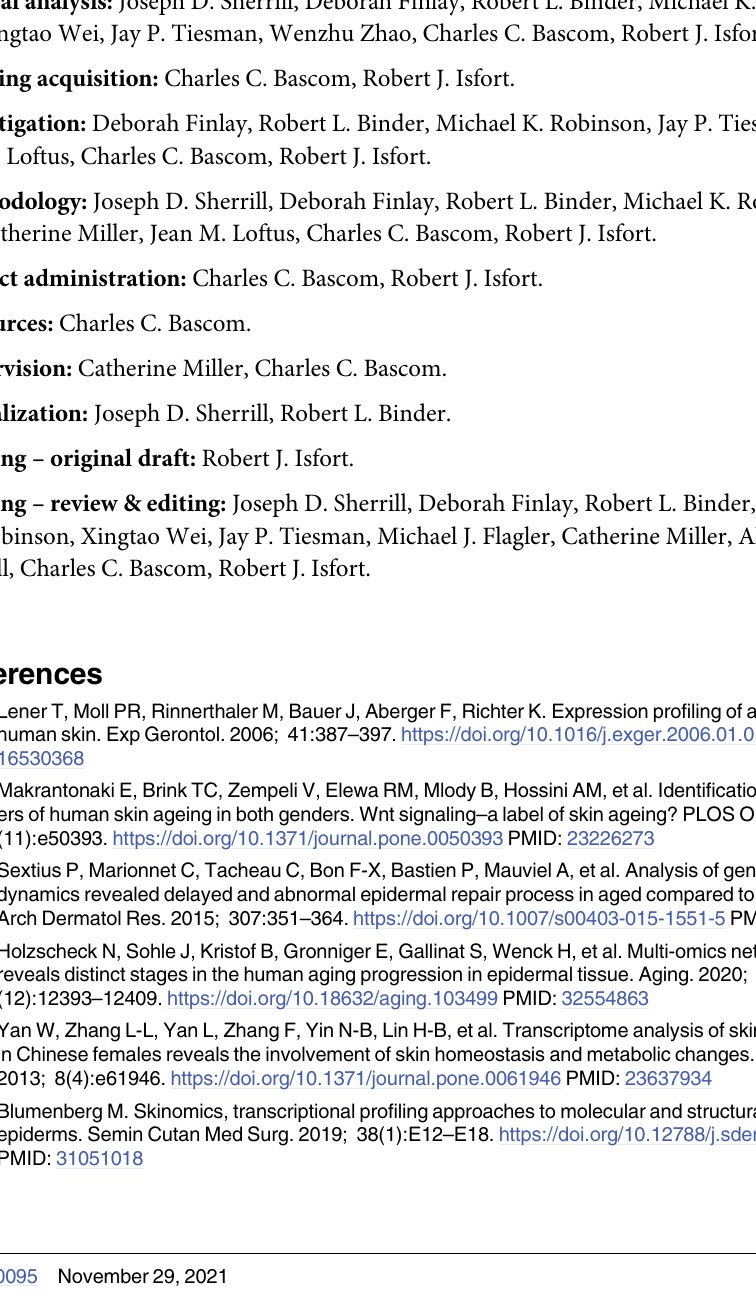
S9 Table. Top 20 molecular functions and system development process annotations associ- ated with 4 laser resurfacing treatments (by Fisher’s